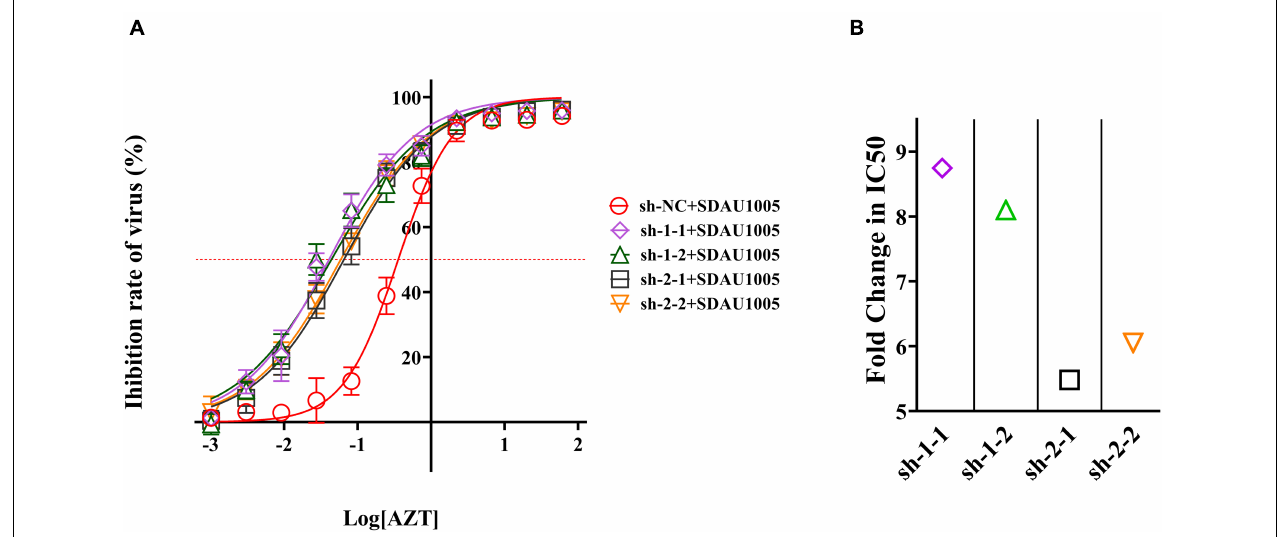
FIGURE 6 | Antiviral activity of AZT was changed under the pressure of specific shRNA. (A) Dose-response curve of AZT in DF-1 cells expressing shRNAs. The x -axis represents the log of the concentration of AZT ( µ g/ml), and the y -axis represents the inhibition rate of virus (%), which was calculated according to Equation 2 and represents the proportion of virus titer reduction under drugs. The red dotted line indicates the position of 50% inhibition rate, according to which we can observe the shift of IC 50 . The experiment was repeated four times. The error bars represent the SD. (B) The fold change of IC 50 . The IC 50 values were generated by fitting the inhibition curves, and the FCIC 50 was calculated as Equation